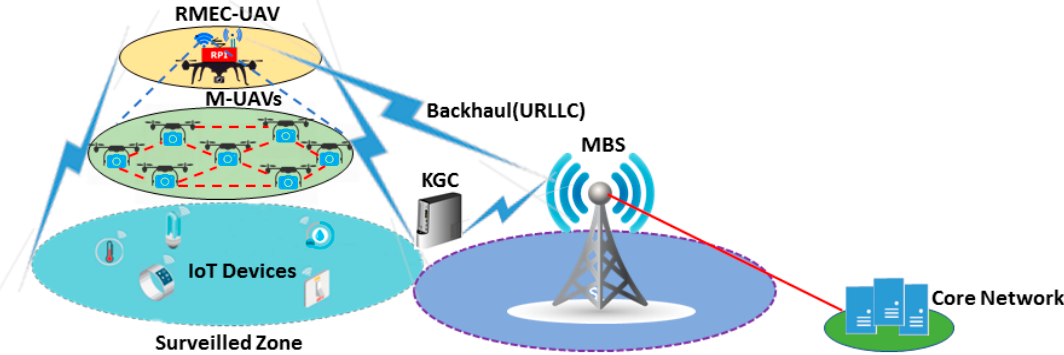
Figure 2. Proposed architecture of flying ad-hoc network with 5G and multi-access edge computing (MEC) facilities. RMEC-UAV: raspberry pi-based multi-access edge computing unmanned aerial vehicle, M-UAV: monitoring UAV, IoT: Internet of Things, URLLC: ultra-reliable low